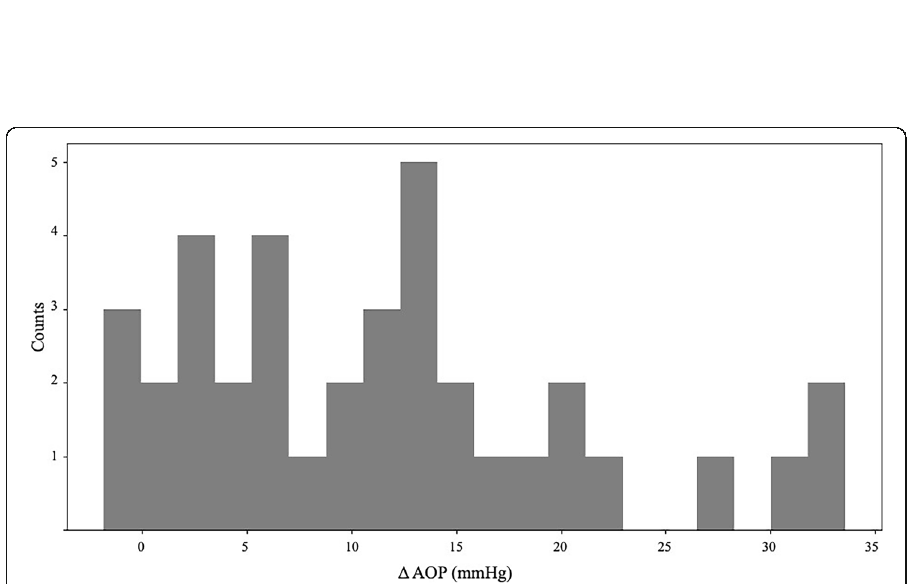
Fig. 4 This histogram of the change in mean aortic pressure was calculated by subtracting the mean aortic pressure 36-40 s before the calcium bolus from the mean aortic pressure 36-40 s after the calcium bolus. While most of these interventions are associated with a positive change in mean aortic pressure, in four experiments, the mean aortic pressure decreased. In these experiments, the animal was decompensating rapidly, and the continuing drop in blood pressure was larger than the benefit of the calcium